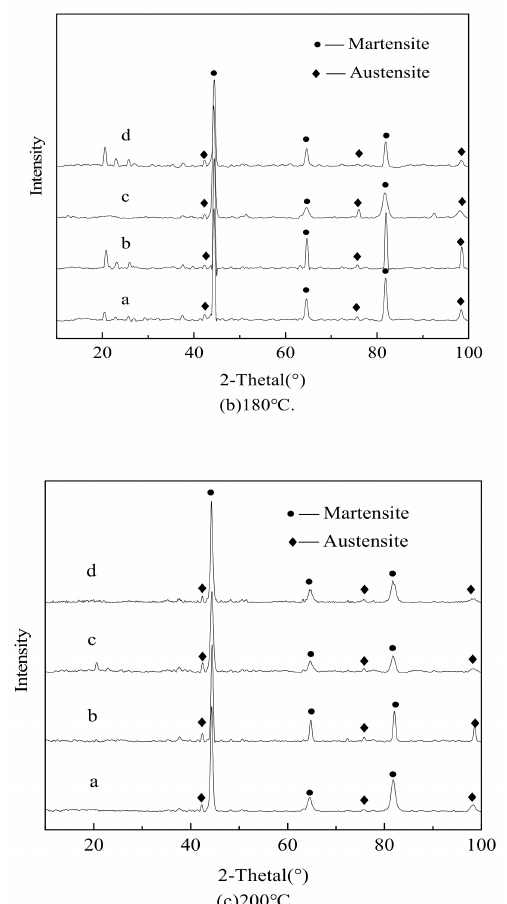
Figure 1. Spectra under di ff erent stresses at di ff erent temperatures; ( a ) 160 ◦ C; ( b ) 180 ◦ C; ( c ) 200 ◦